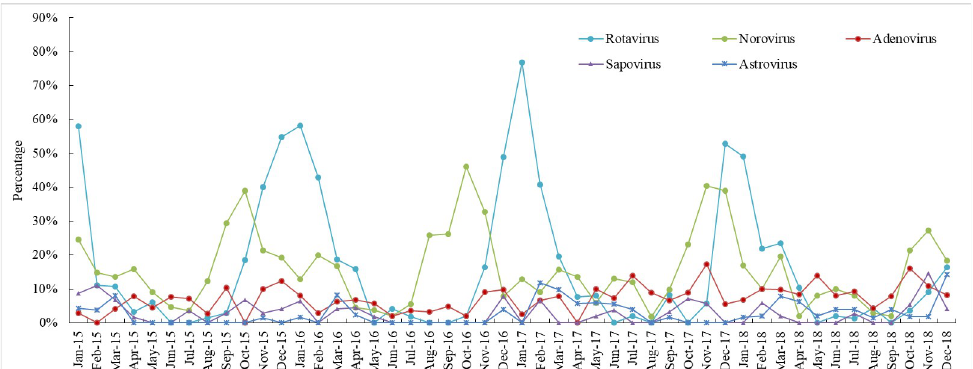
Fig 1. Seasonal prevalence of viruses in children with acute diarrhoea in